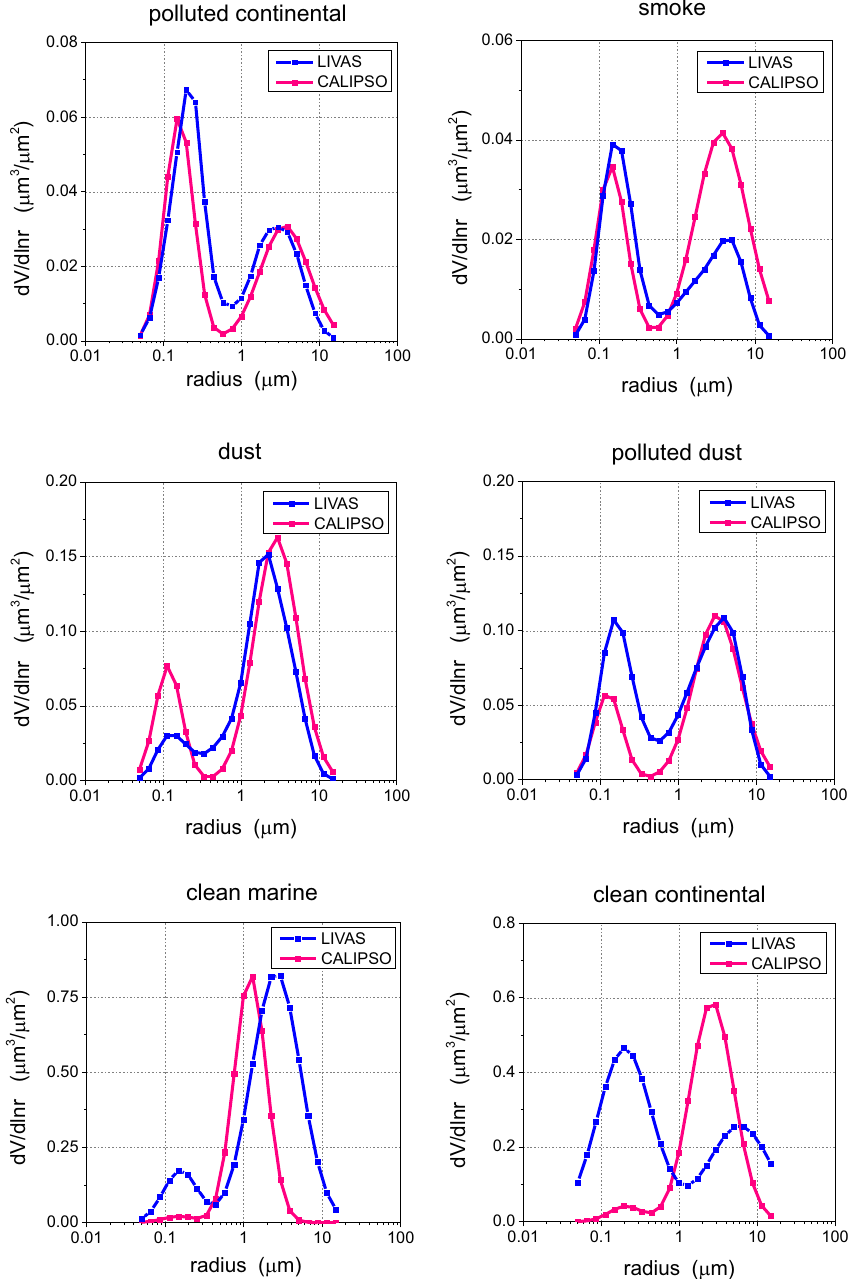
Figure 3. Comparison of the mean volume–size distributions for each aerosol type in the LIVAS (blue line) and CALIPSO (pink line) aerosol